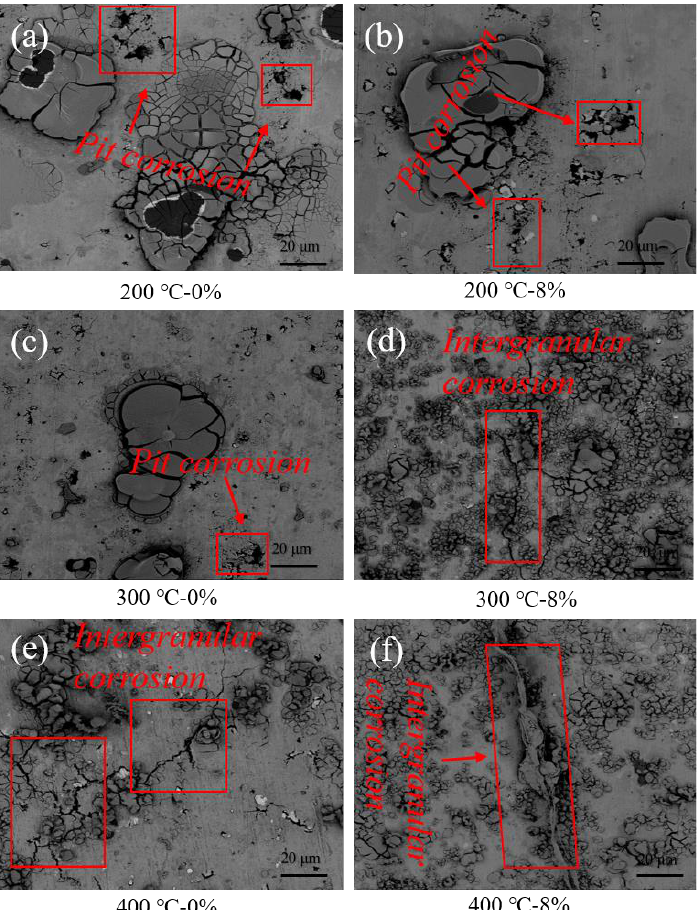
Figure 8. SEM figures of corrosion morphology. ( a ) Without strain under peak temperature of 200 ℃ ; ( b ) 8% pre-strain was given at peak temperature of 200 ℃ ; ( c ) Without strain under peak temperature of 300 ℃ ; ( d ) 8% pre-strain was given at peak temperature of 300 ℃ ; ( e ) Without strain under peak temperature of 400 ℃ ;( f ) 8% pre-strain was given at peak temperature of 400 ℃ .